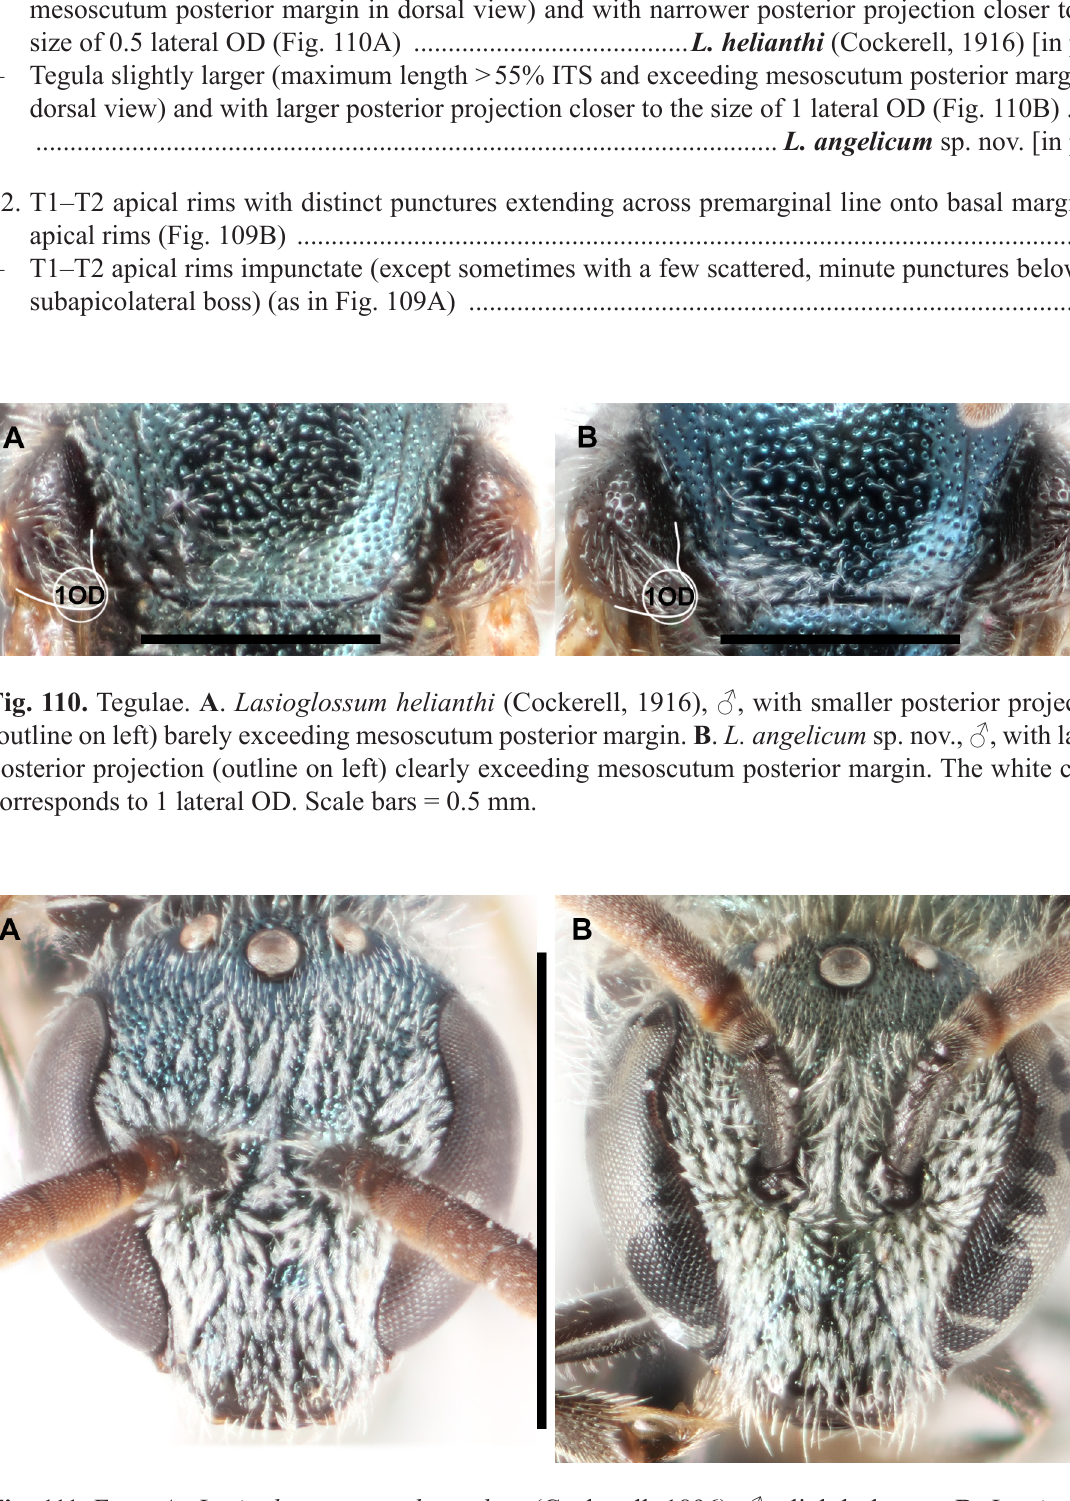
Fig. 111. Face. A . Lasioglossum pseudotegulare (Cockerell, 1896), ♂, slightly longer. B . L. stictaspis (Sandhouse, 1923), ♂, slightly shorter. Scale bars = 1